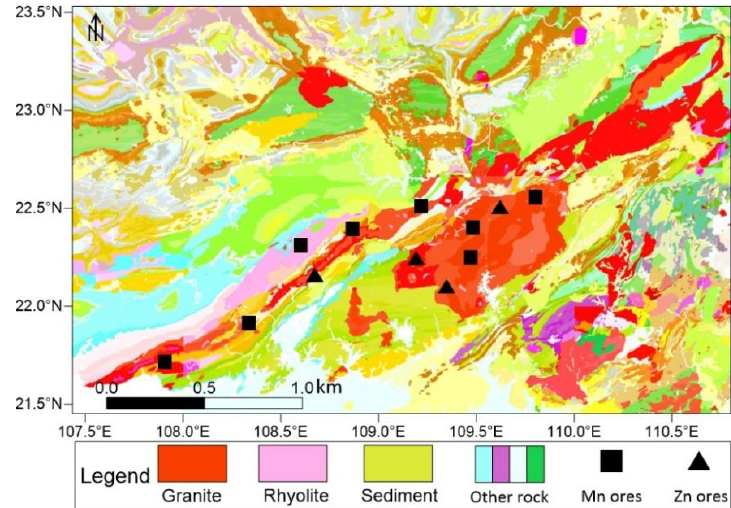
Figure 9. Geological map (1:200,000) and mineral distribution around the Qinjiang River (Adapted with permission from Ref. [56]).